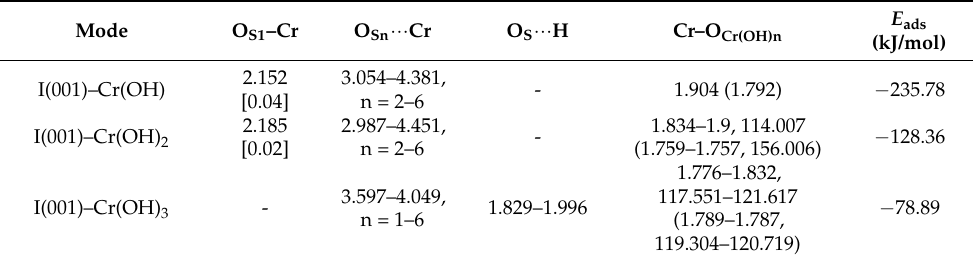
Figure 2. Stable configurations of Cr(OH) n(3 − n)+ adsorbed on the illite (001) surface. Table 1. Calculated energy characteristics (kJ/mol) and structural parameters (Å) of Cr(OH) n(3 − n)+ adsorbed on the illite (001) surface.